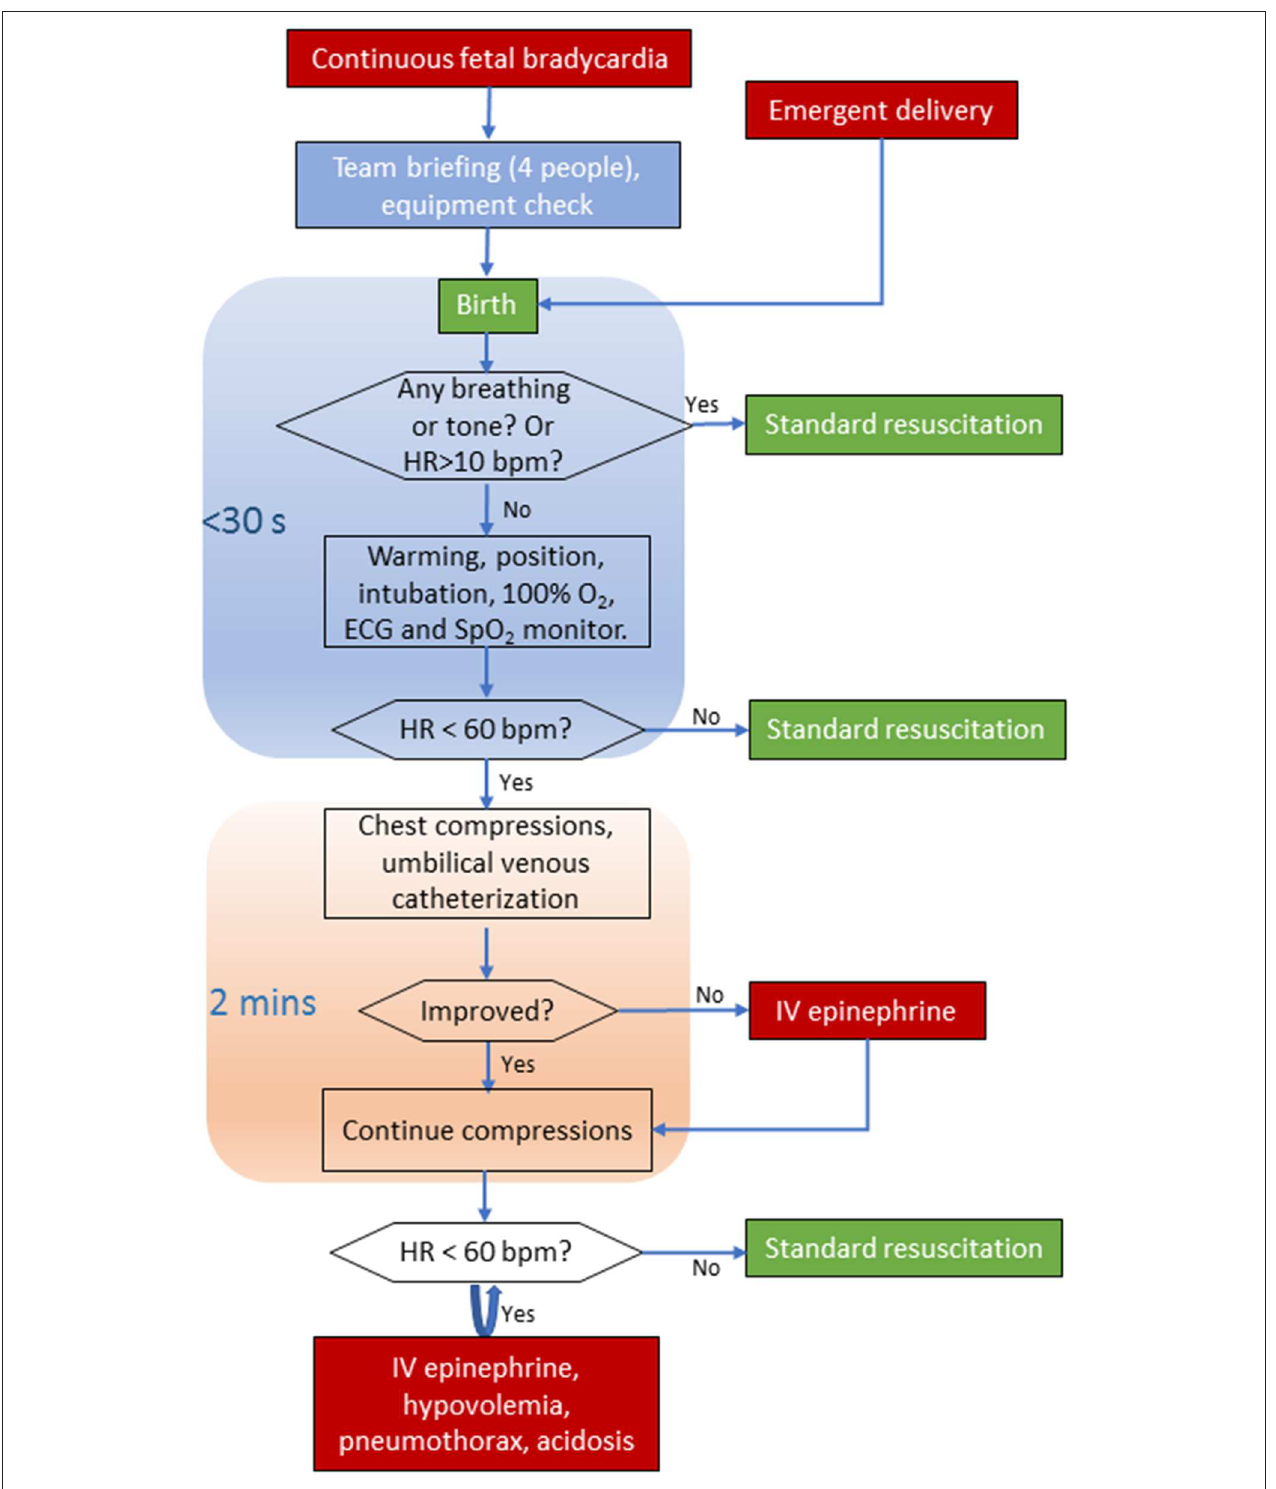
FIGURE 1 | Algorithm for the resuscitation of asphyxiated newborns with asystole or severe bradycardia. ECG, electrocardiography; SpO 2 , saturation pulse oxygen; HR, heart rate; bpm, beats per minute; IV, intravenous.